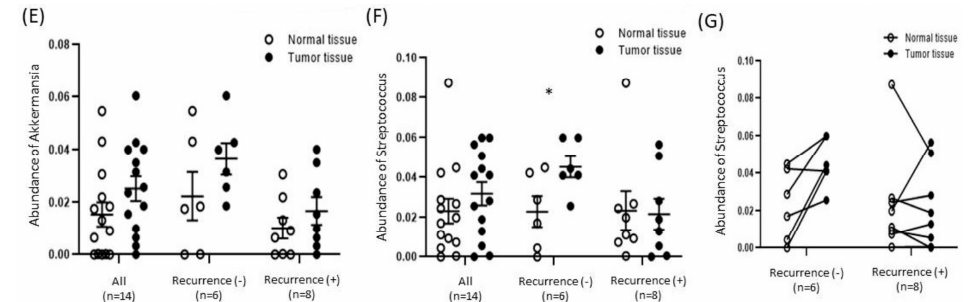
Figure 3. Comparative analysis of the extracellular vesicle (EV)-derived microbiomes according to tumor recurrence: ( A ) comparison of alpha diversity indices between tumor and normal tissues according to the presence of tumor recurrence, ( B ) clustering of common microbiota in paired tumor and normal tissues according to the presence of tumor recurrence, ( C ) alpha diversity rarefaction plots for the EV-derived microbiomes in tumor and normal tissues according to the presence of tumor recurrence (mean ± SEM, *** p < 0.001), ( D ) specific microbiota taxa with increased abundance in tumor tissues according to the presence of tumor recurrence (mean ± SEM, * p < 0.05), ( E ) comparison of the abundance of Akkermansia in tumor and normal tissues according to the presence of tumor recurrence (mean ± SEM, * p < 0.05), and ( F , G ) comparison of the abundance of Streptococcus in tumor and normal tissues according to the presence of tumor recurrence (mean ± SEM, * p <